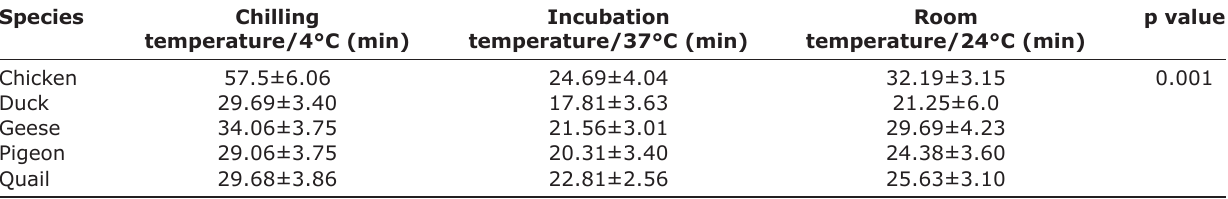
Table-1: Time required for HA of avian RBC with NDV (lasota strain) at different temperatures (mean±SD). Species